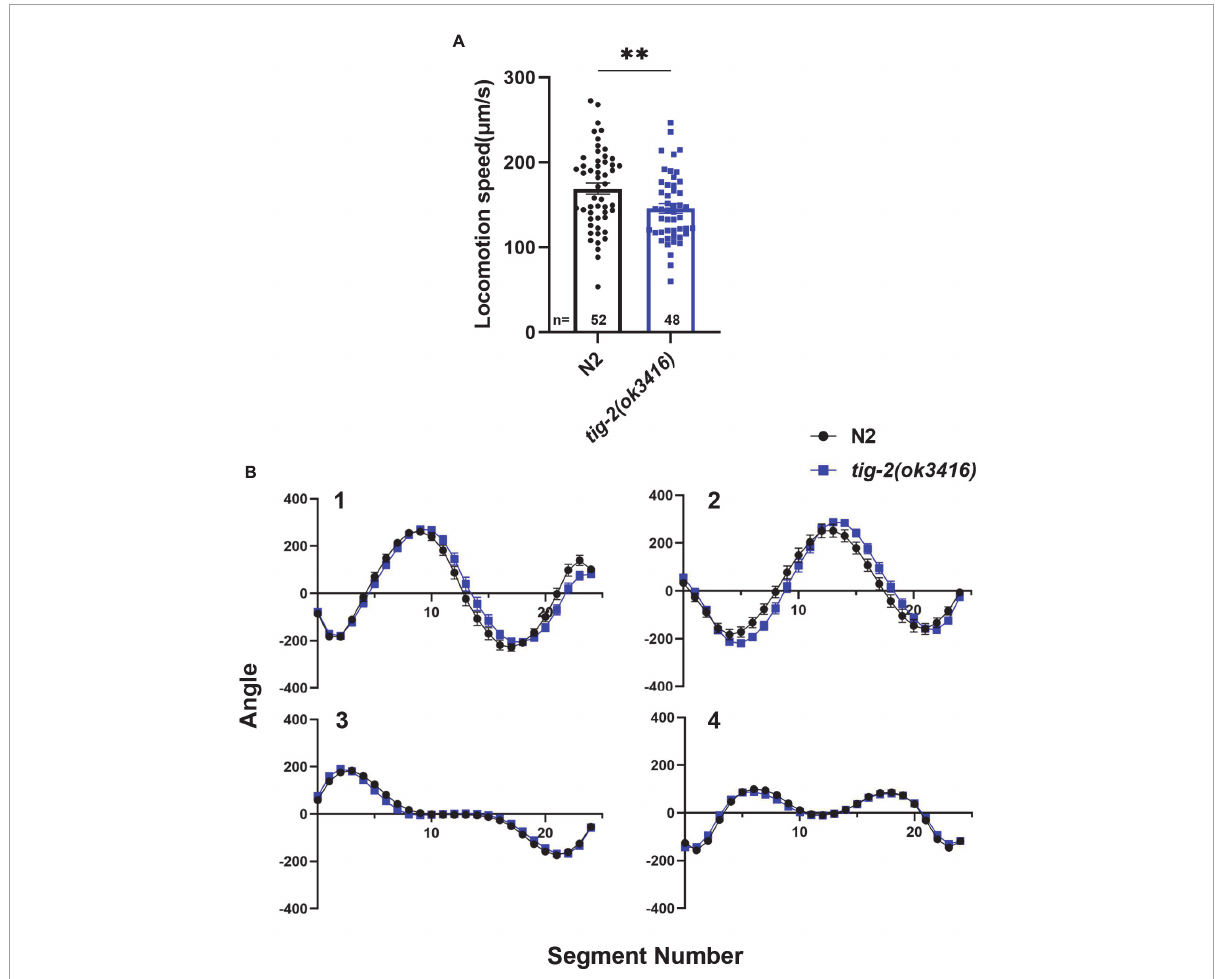
FIGURE1 tig-2 mutant displays lower locomotion speed than wild-type worms. (A) tig-2 ( ok3416 ) mutant has a lower locomotion speed is lower in on day 3 compared to wild-type animals ( p = 0.0099). (B) The four eigenworms derived from wild-type worms and tig-2 ( ok3416 ) mutants are similar. A student’s t -test was performed to determine the significance of differences in locomotion speed. Error bars represent SEM. ∗∗ p <